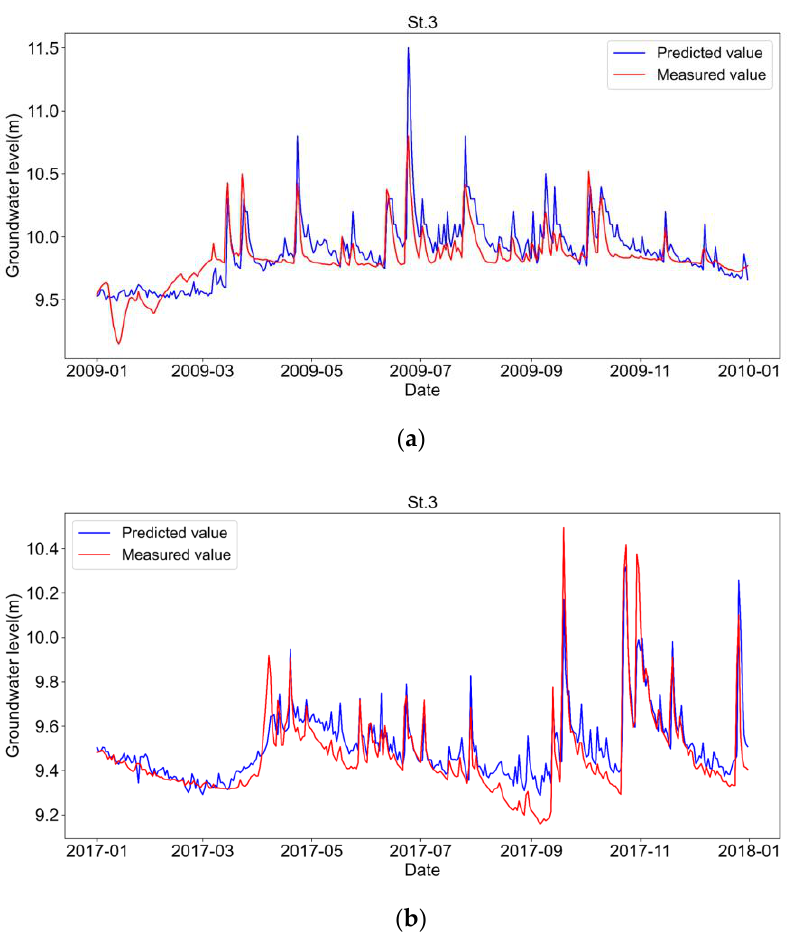
Figure 8. Time series of groundwater levels at St.3 from both the LSTM prediction and field observation: ( a ) Before the meandering stream channel restoration in 2009. ( b ) After the meandering stream channel restoration in 2017. Table 2. RMSEs before and after the meandering stream channel restoration.